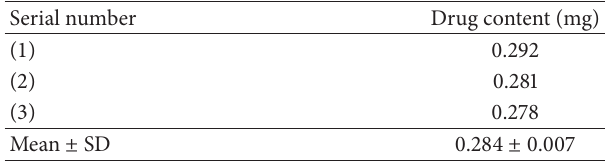
Table 4: Weight uniformity of patch.